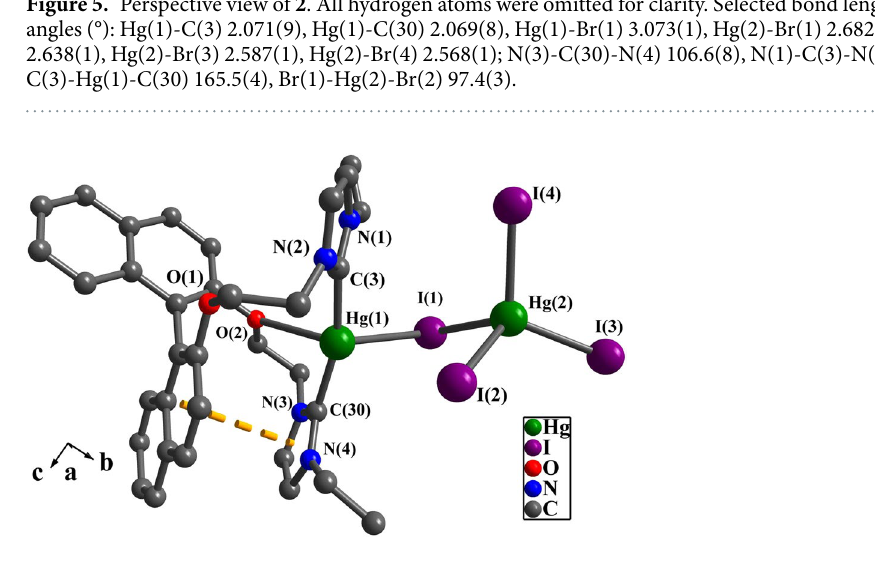
Figure 6. Perspective view of 3 . All hydrogen atoms were omitted for clarity. Selected bond lengths (Å) and angles (°): Hg(1)-I(1) 3.204(6), Hg(1)-C(30) 2.068(7), Hg(1)-C(3) 2.066(7), Hg(2)-I(1) 2.855(6), Hg(2)-I(2) 2.788(7), Hg(2)-I(3) 2.732(7), Hg(2)-I(4) 2.743(7); N(1)-C(3)-N(2) 105.9(6), N(3)-C(30)-N(4) 106.9(6), C(3)- Hg(1)-C(30) 164.6(3), C(30)-Hg(1)-I(1) 91.1(1), I(1)-Hg(2)-I(2)